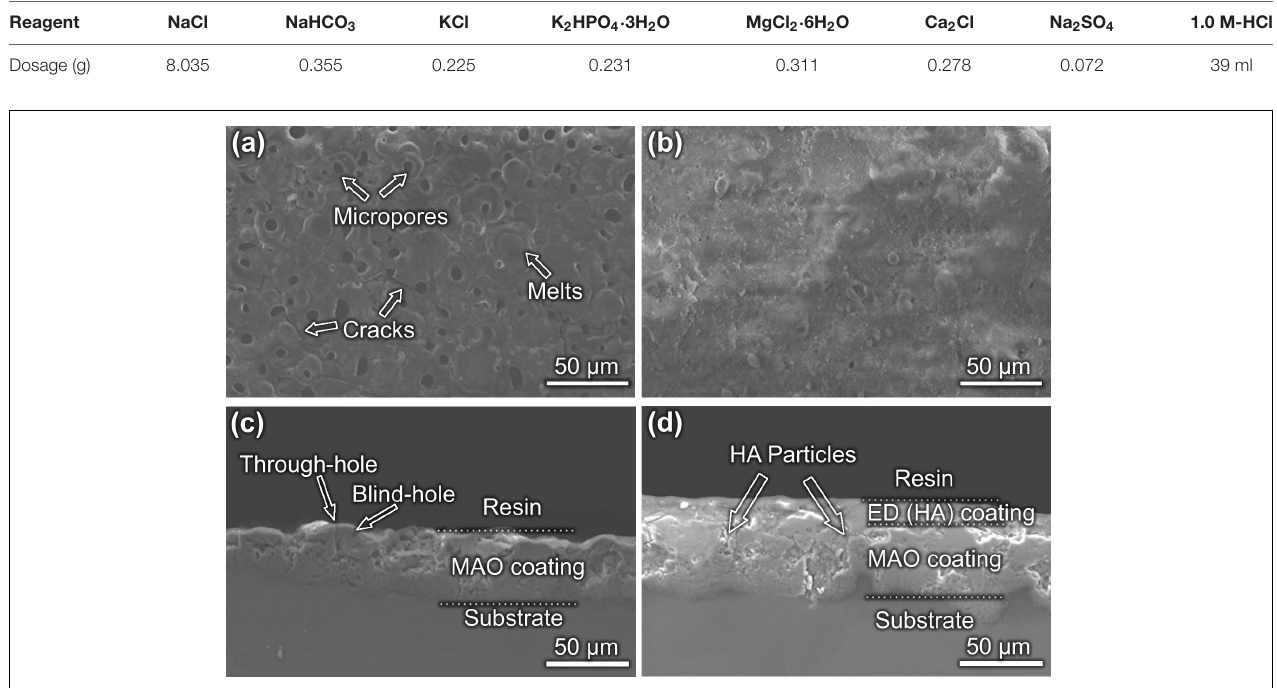
TABLE 2 | Reagents and dose for 1,000 ml SBF.